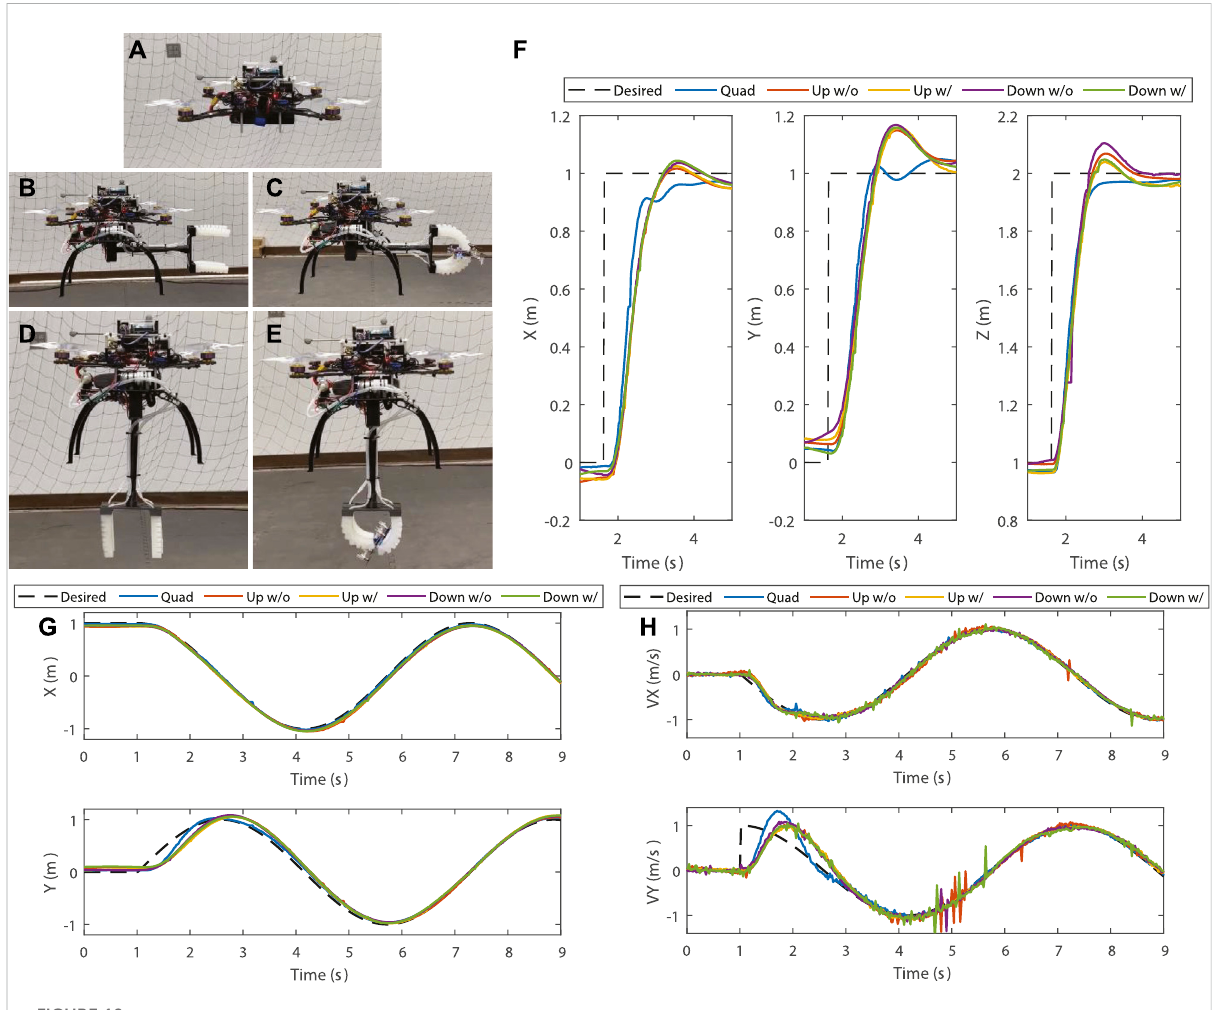
FIGURE 10 Free fl ight tracking test. (A – E) Five cases are considered inthe test: conventional quadrotor (Quad), SoAG robot with arm up without target (Up w/o), SoAG robot with arm up with target (Up w/), and SoAG robot with arm down without target (Down w/o). (F) States for all robots in the step response test. (G) Positions and (H) Velocities on x W and y W axis for the planar circle tracking